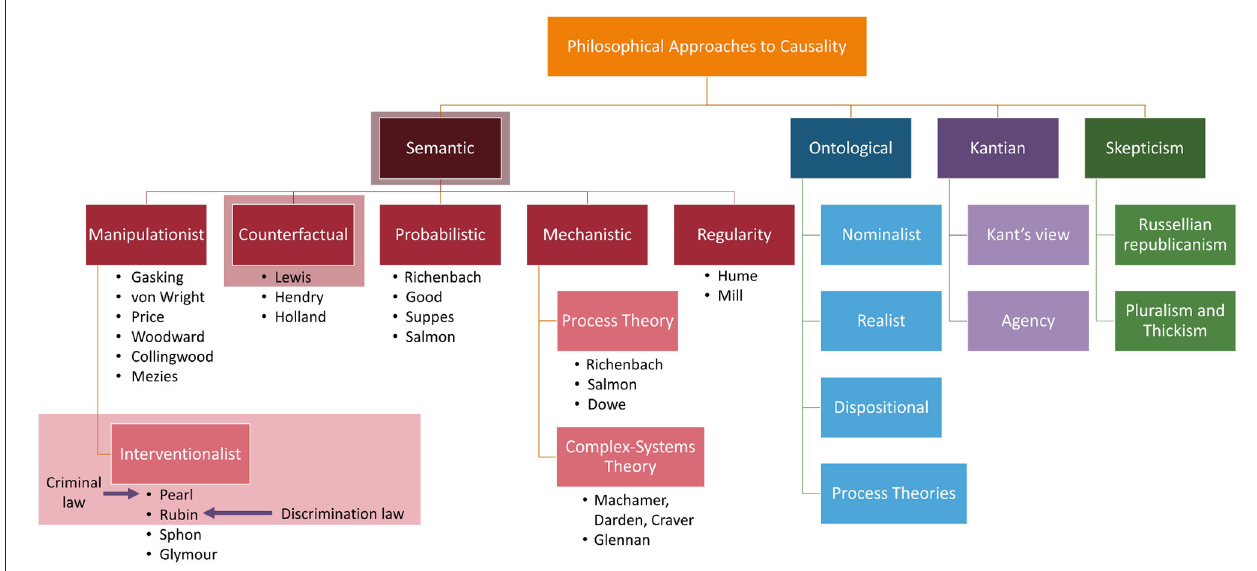
FIGURE 6 | The multiple different approaches to causality. The first level indicates the types of questions that can be asked about causality and the rows below are answers to the questions. For example, probabilistic approaches are an answer to semantic questions. The shadow-boxed items are elements discussed in this publication: interventionalist approaches of Pearl and Rubin as well as the counterfactual groundings of both based on Lewis’ work. Additionally, we map where two different types of U.S. legal cases fall within the causal framework. We refer interested readers to Broadbent (2020) for details on the approaches not